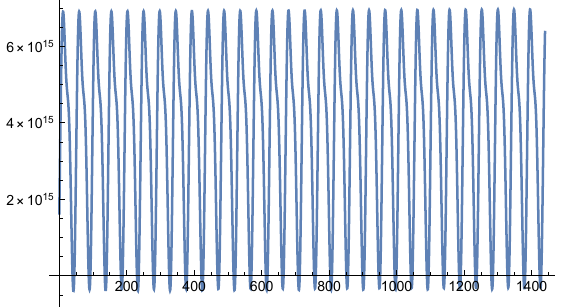
Fig. 4 Visibility Intervals Between HST and ODIN For